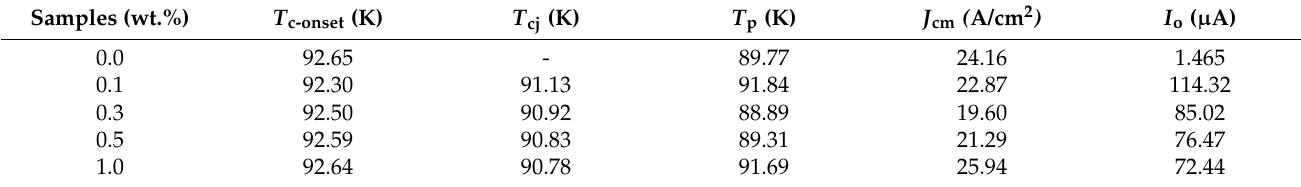
Table 3. Onset critical temperature, T c-onset , phase lock-in temperature, T cj , coupling temperature, T p , critical current density, J cm and Josephson current, I o of the Y123 added with graphene nanoparticles samples in AC field of 0.5